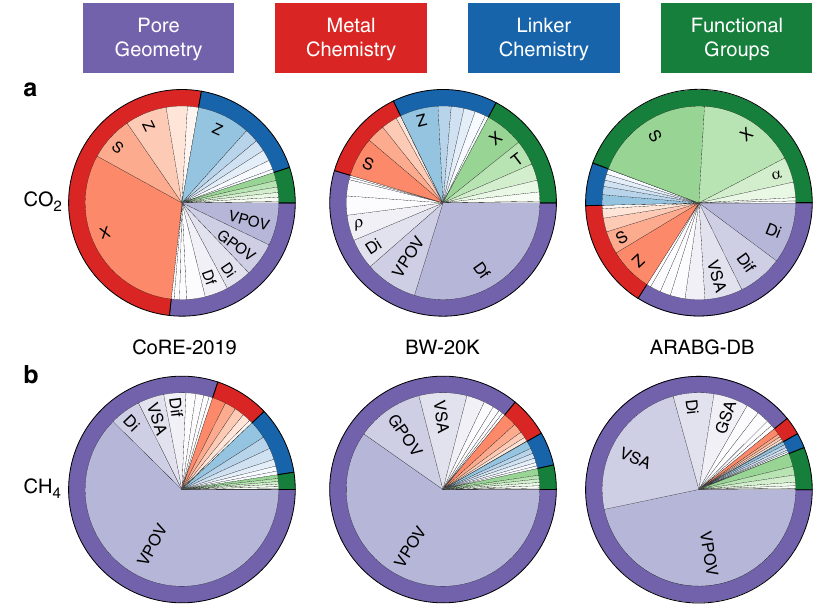
Fig. 4 Database dependence of the importance of material characteristics. Pie charts showing the SHapley Additive exPlanations (SHAP) values (importance of variables) for a the low-pressure CO 2 adsorption and b CH 4 deliverable capacity. SHAP values were computed for the random forest regression models using a training set of CoRE-2019 and BW-20K, and all structures in ARABG-DB. For the chemical features, the importance of variables was summed over all RAC depths for each of the heuristic atomic properties. See the “ Methods ” section for the meaning of the labels. Similar values for importance of variables were obtained using other techniques (see Supplementary Note